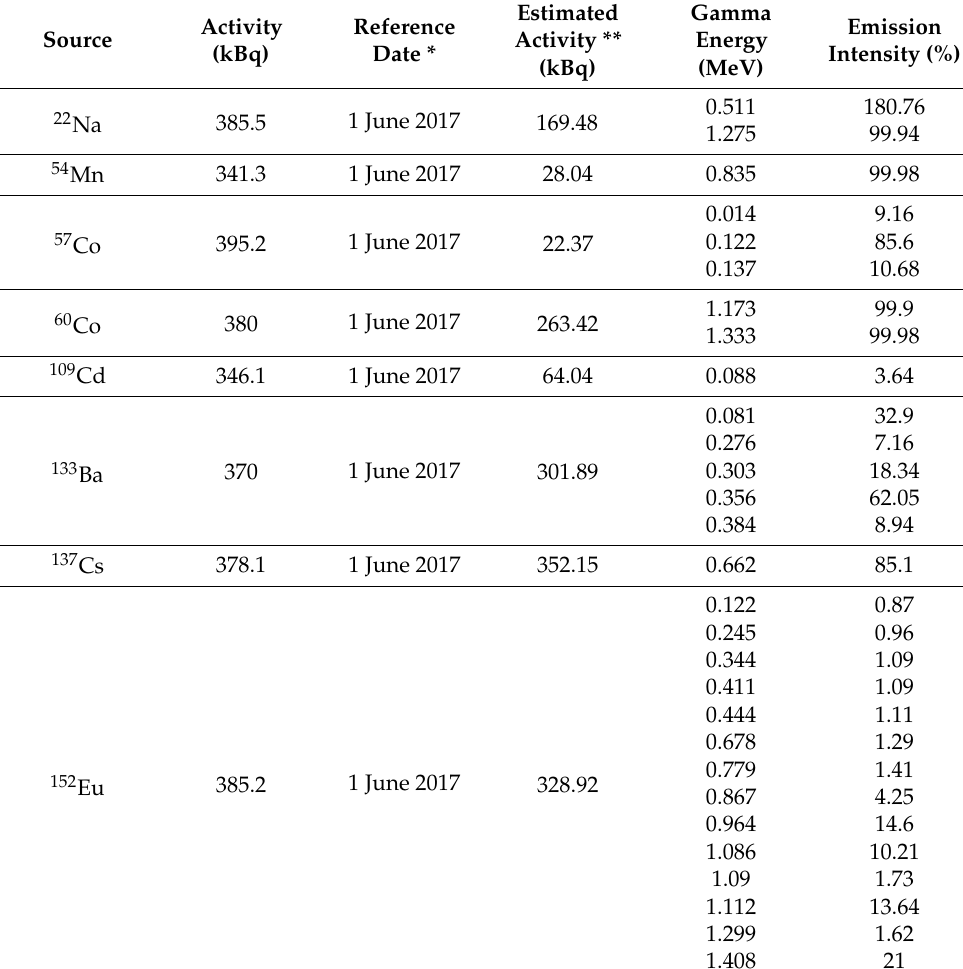
Table 1. Details of the used gamma-ray